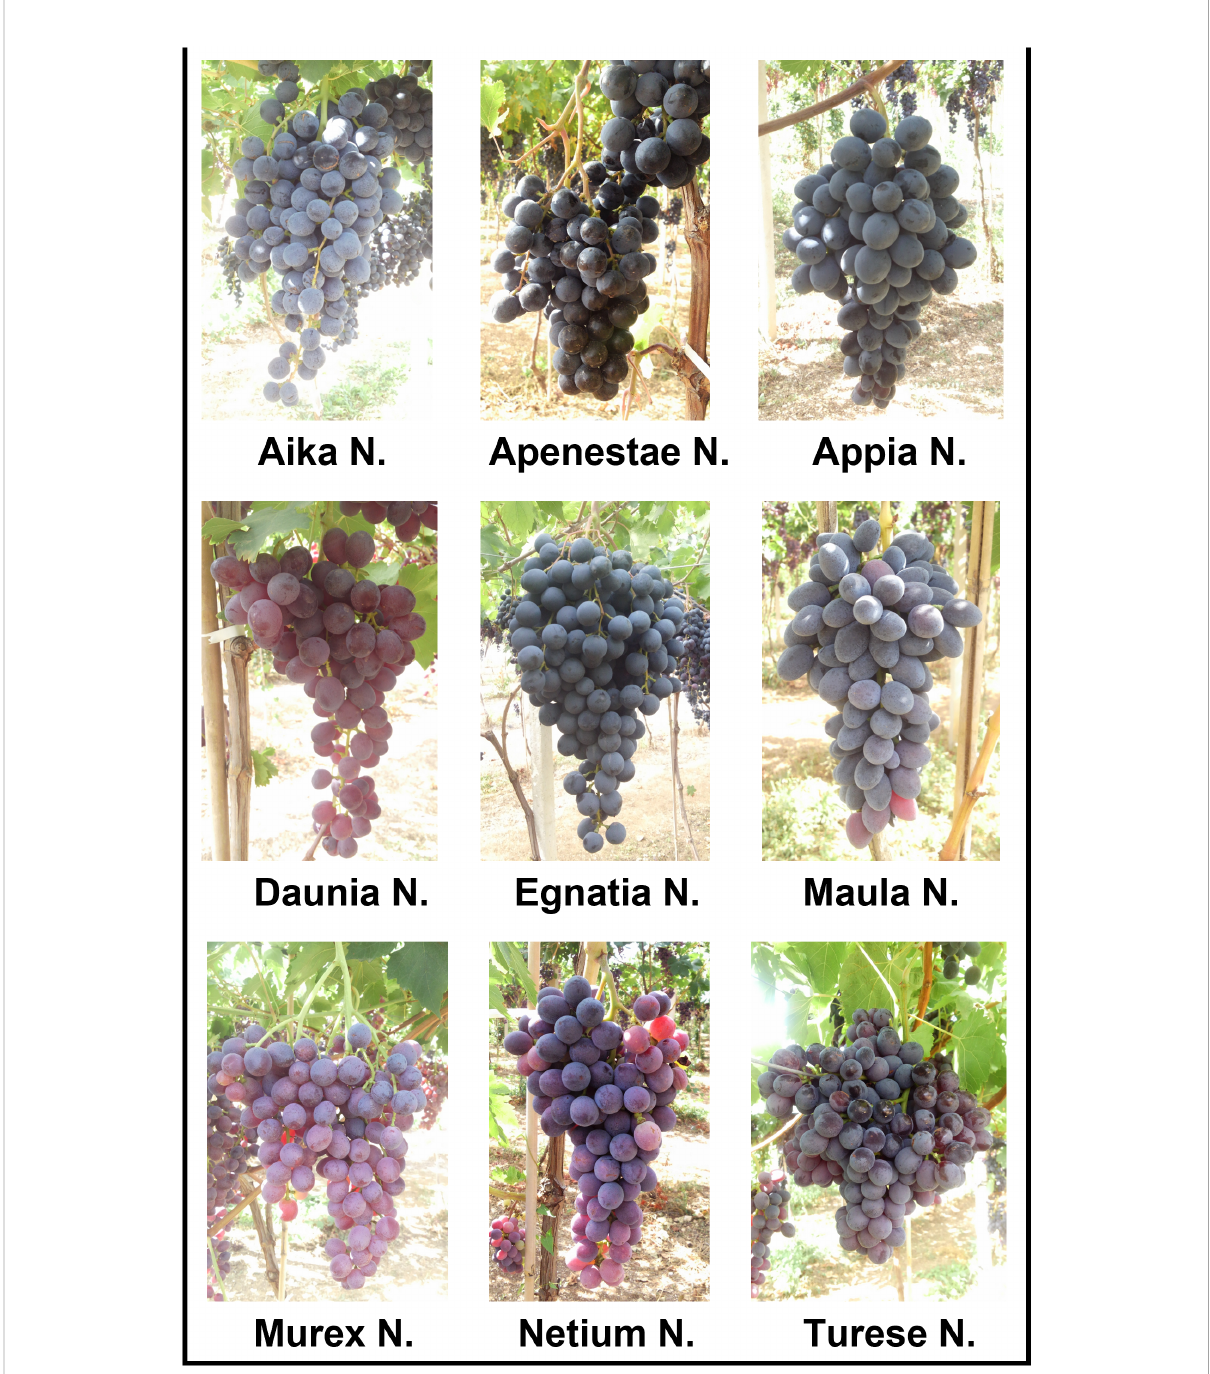
FIGURE 1 Nine new seedless grape genotypes, ‘ Aika N. ’ , ‘ Apenestae N. ’ , ‘ Appia N. ’ , ‘ Daunia N. ’ , ‘ Egnatia N. ’ , ‘ Maula N. ’ , ‘ Murex N. ’ , ‘ Netium N. ’ , ‘ Turese N. ’ , selected from a breeding program carried at the CREA-Research Centre for Viticulture and Enology of Turi